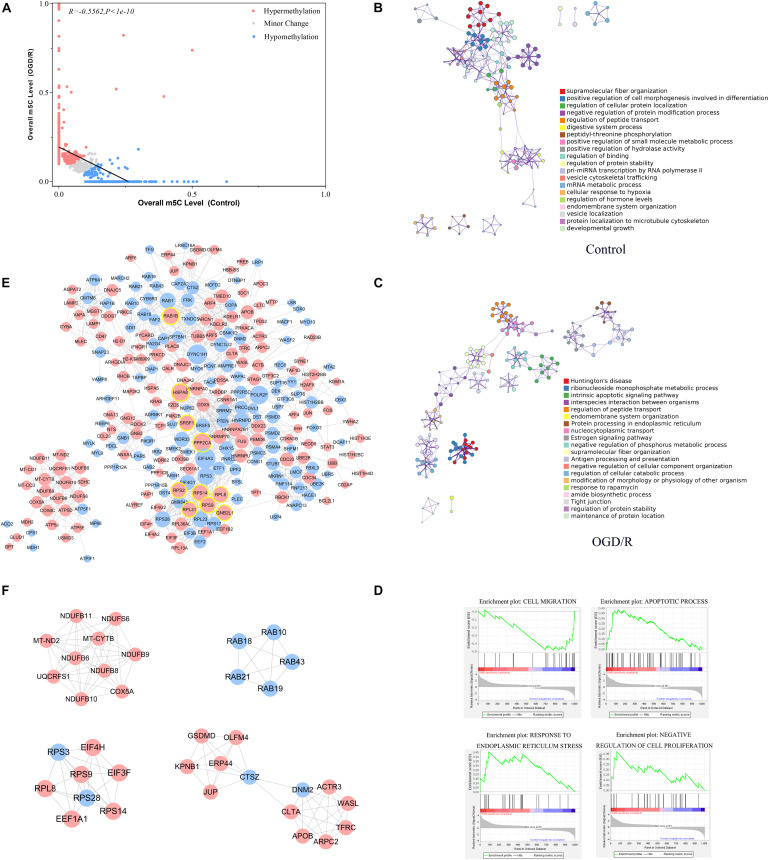
Functional analysis of differentially methylated m5C-modified genes between the control and OGD/R groups. (A) Relationship of the methylation level of m5C transcripts between the control and OGD/R groups. Red dots represent transcripts with increased levels of m5C modifications after OGD/R, whereas blue dots represent opposite attributes. Regression lines are shown, and the Pearson correlation coefficient (R) was calculated by GraphPad Prism. (B,C) Network of enriched terms colored by cluster ID for differentially methylated genes (B, control group; C, OGD/R group). Each term is represented by a circular node, where its size is proportional to the number of input genes that are related to that term and its color represents its cluster identity. Terms with a similarity score > 0.3 are linked by a line (thickness of the line represents the similarity score). (D) GSEA of differentially m5C-modified genes with GO gene sets. (E) PPI network analysis of differentially expressed m5C-modified genes. Red nodes represent hypermethylated genes, and blue nodes represent hypomethylated genes. The top 10 nodes of hypermethylated genes are marked with yellow circle. (F) The 5 most meaningful modules selected from the PPI network using MCODE plug-in.